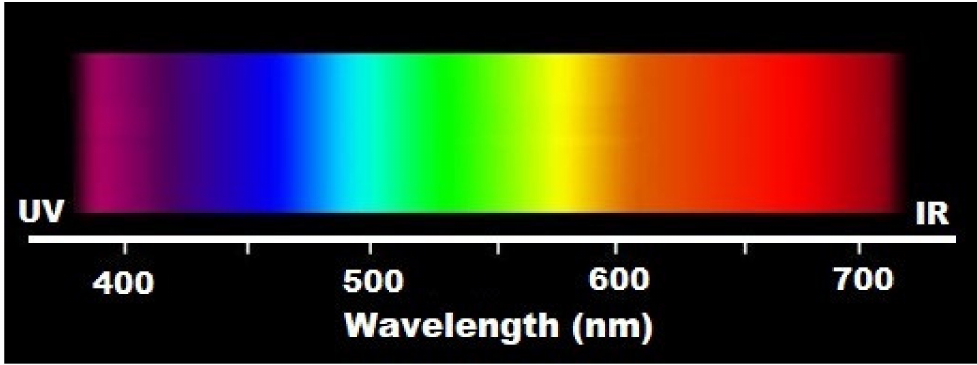
Figure 2. Wavelengths applied in